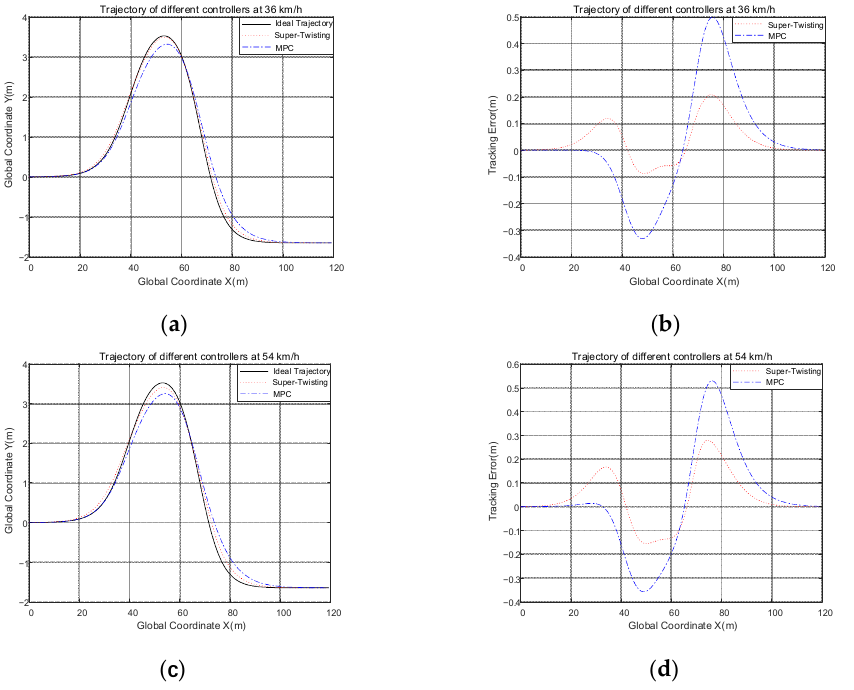
Figure 9. ( a ) Comparison of trajectories at 36 km/h; ( b ) comparison of the tracking error at 36 km/h; ( c ) comparison of trajectories at 54 km/h; ( d ) comparison of the tracking error at 54 km/h. As seen from Figure 9, in the two different speed conditions, the trajectory of the ST controller is more closely aligned to the ideal trajectory than the MPC controller, and the ST